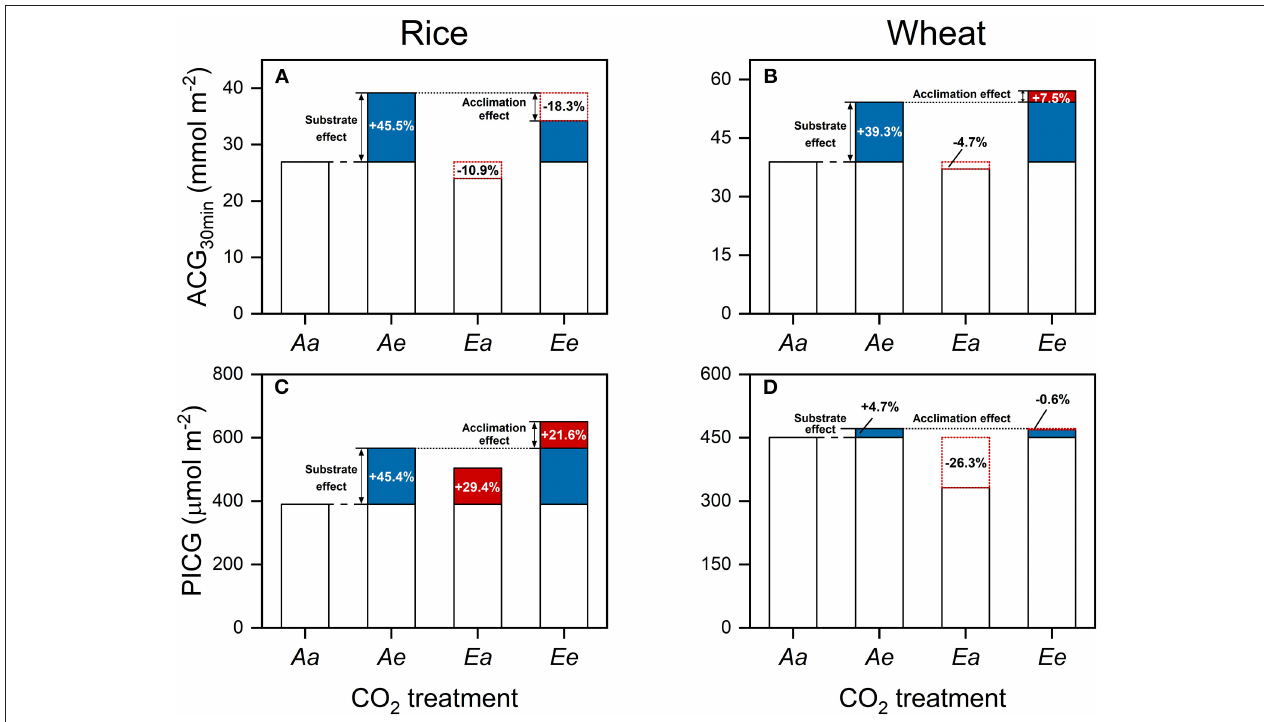
FIGURE 4 | Accumulative carbon gain during a time period of 30min following an increase in light intensity from 100 to 1,500 µ mol photons m − 2 s − 1 (A,B) and during the post-illumination period (C,D) in rice (A,C) and wheat (B,D) leaves. Values are means of three to four biological replicates, i.e., individual plants for each species. Blue-filled bars lines indicate the substrate effect of eCO 2 , whereas red-filled and open bars with red dotted frames indicate the acclimation effect of eCO 2 . Numbers indicate the extent of the substrate and acclimation effect of eCO 2 on ACG, taking ACG 30min under the Aa treatment as the base